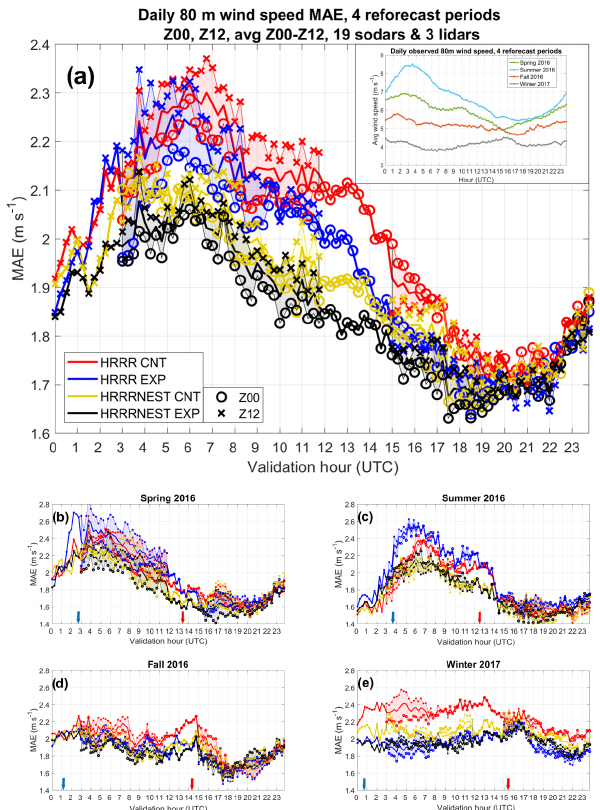
Figure 1. Diurnally averaged 80m wind speed MAEs for HRRR CNT (red curves), HRRR EXP (blue curves), HRRRNEST CNT (yellow curves), and HRRRNEST EXP (black curves). Panel (a) shows the MAEs averaged over the four reforecast periods; panel (b) are MAEs for the spring 2016 reforecast period, (c) for summer 2016, (d) for fall 2016, and (e) for winter 2017. Initial- ization times at 00:00UTC (Z00) are represented by circles and at 12:00UTC (Z12) with X’s, while the solid bold lines are the aver- ages between the Z00 and Z12 values. Red and blue arrows on the y axes represent the sunrise and sunset times, respectively. Aver- aged observed 80m wind speeds are presented in the insert of panel (a) for the four reforecast periods for